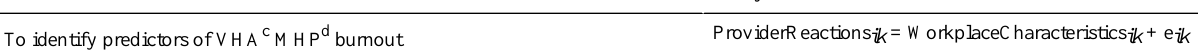
Analytical model a,b Quantitative